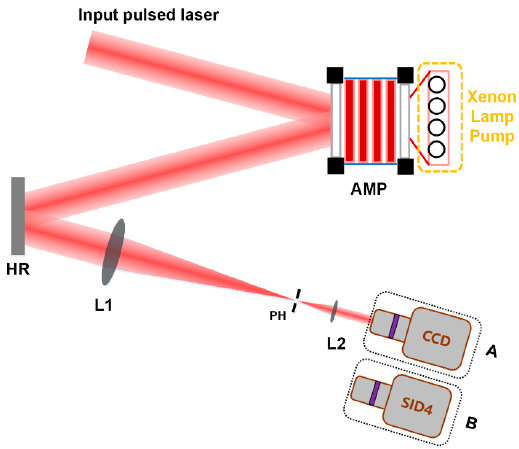
Figure 11. Schematic diagram of the experiment for measuring laser amplifier performance. AMP: direct-liquid-cooled split-disk laser amplifier; L1: lens with f = 1000 mm; L2: lens with f = 50 mm; HR: fused silica with high-reflection coating for 1064 nm; PH: pinhole plate; A: CCD used for measuring the pump distribution; B: wavefront sensor SID4 used for measuring the thermally induced wavefront.